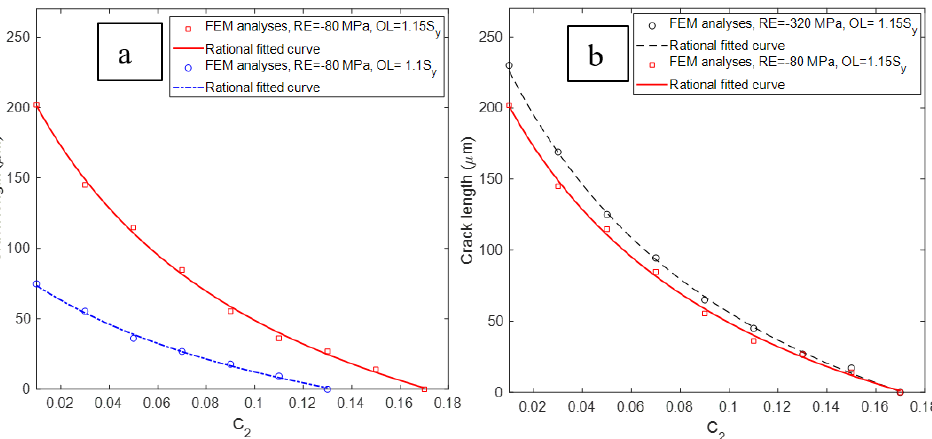
Figure 18. Influence of ( a ) overload and ( b ) residual stress on the damage and crack size with the C 2 parameter effect.